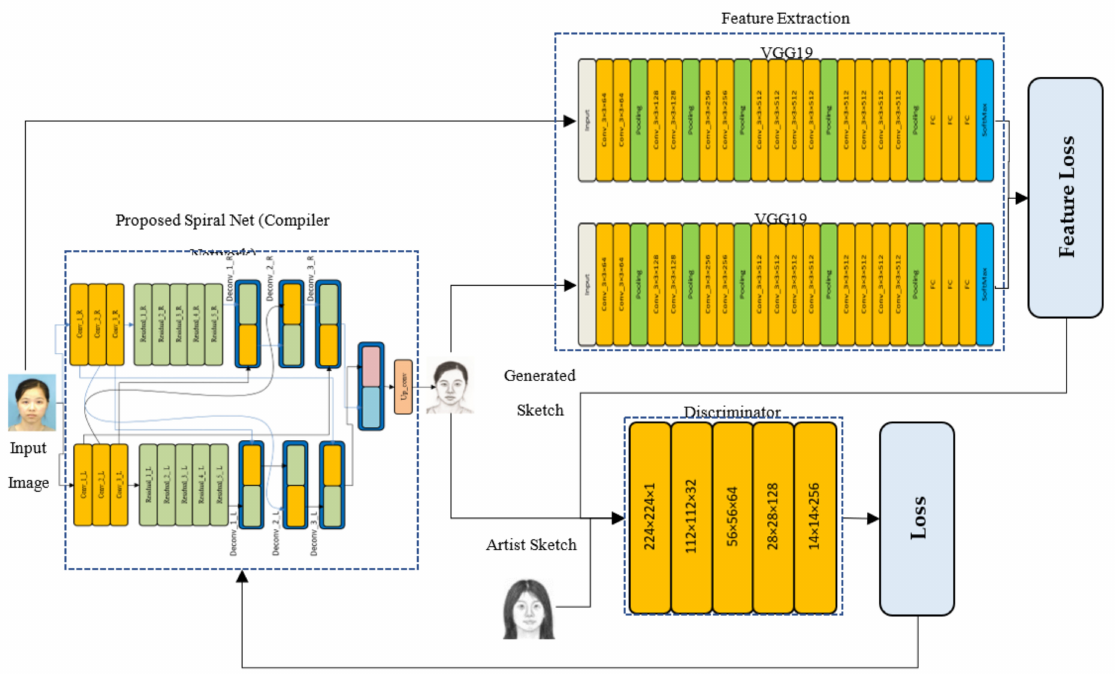
Figure 1. Schematic diagram of the proposed